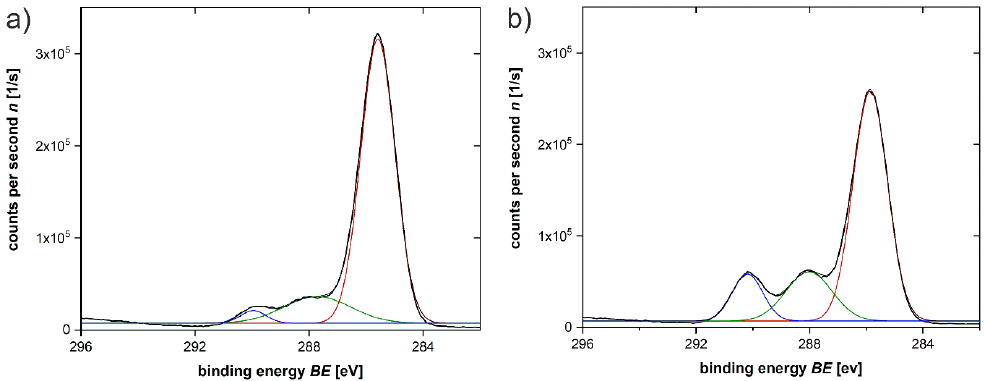
Figure 5. XPS spectra of the PLA: ( a ) untreated, ( b ) treated with 1.0 mol/L NaOH for 8 h.